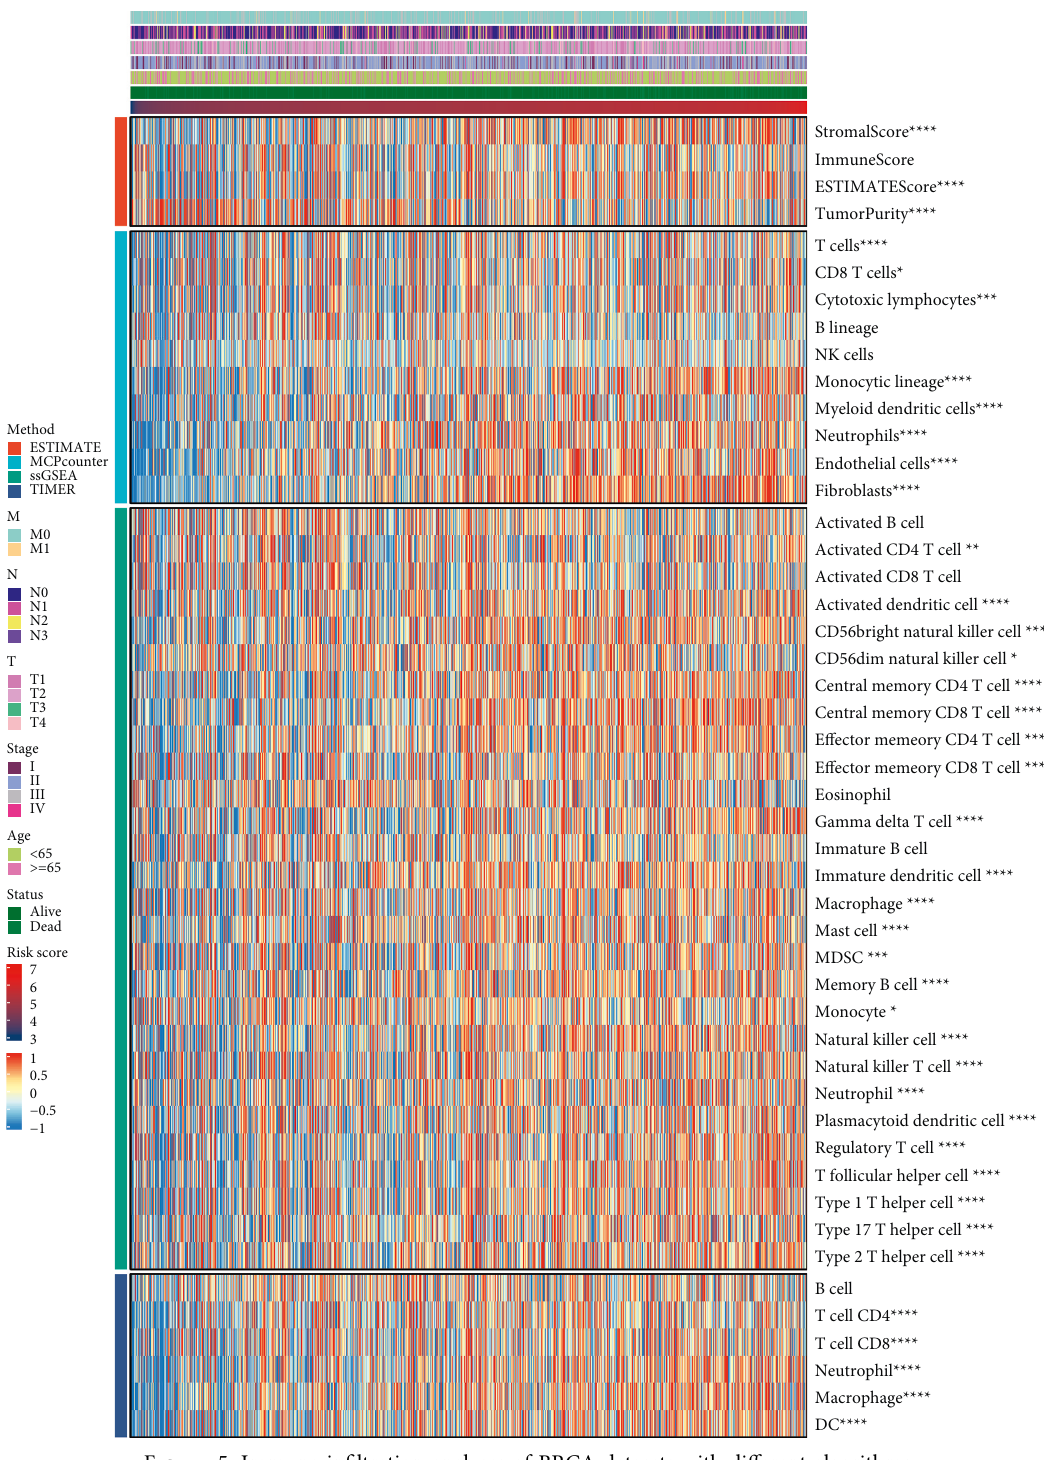
Figure 5: Immune infiltration analyses of BRCA datasets with different